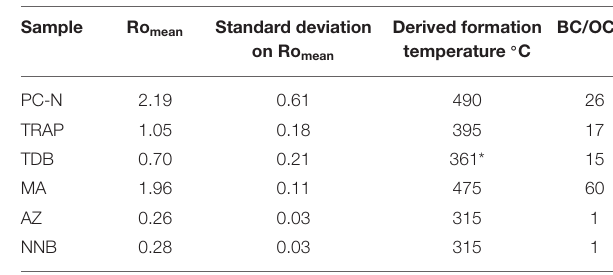
TABLE 2 | Results of Reflectance Spectroscopy and Hydropyrolysis (HyPy) investigations [Black Carbon (BC) as a proportion of Organic Carbon (OC)] performed upon the sample materials listed in Table 1